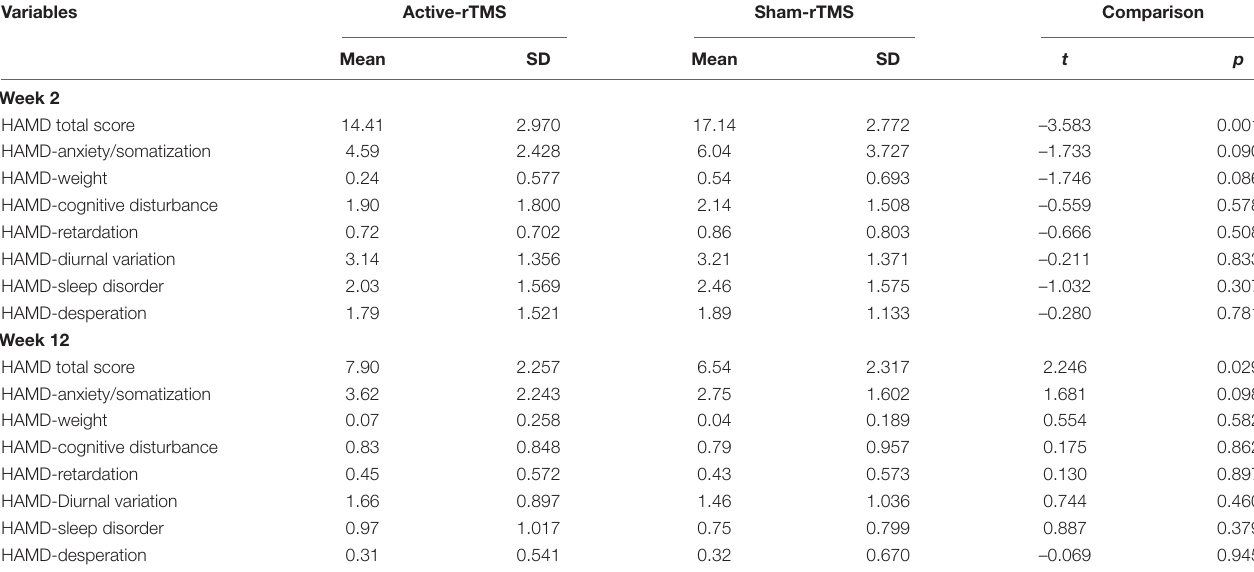
TABLE 2 | Hamilton Rating Scale for depression (HAMD) scores at 2 and 12 weeks in the active-rTMS and sham-rTMS groups in patients with depression. Variables Active-rTMS Sham-rTMS